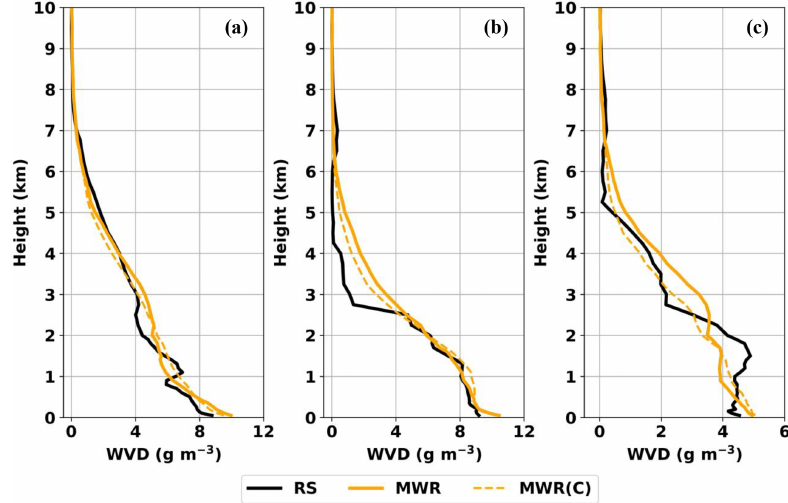
Figure 9. Vertical profiles of water vapor density (WVD) measured by RS and MWR, original and corrected (C), at (a) 23:00UTC on 2 May (precipitation day), (b) 23:00UTC on 28 July (cloudy day), and (c) 11:00UTC on 2 May 2021 (clear-sky day) at Albany.